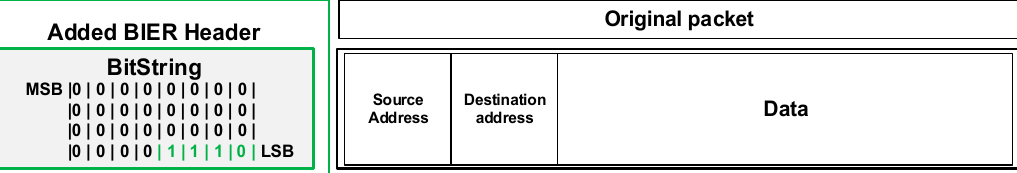
Figure 8. B-REP encapsulation of the IP packet.